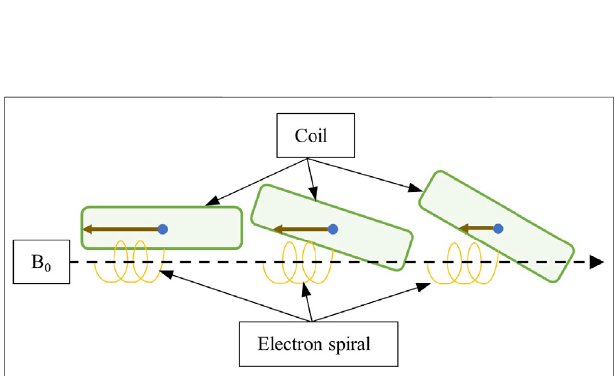
FIGURE 11 | Diagram showing how the coil tilt can affect the electron streaming. Larger tilts (middle and right) create increased distance between the electron spiral and coil surface, meaning the lateral distance the electron must travel to escape and not return to the surface is reduced. Larger tilts also decrease the lateral distances electrons must travel to escape from inside the coil (brown solid arrow) after initial generation.